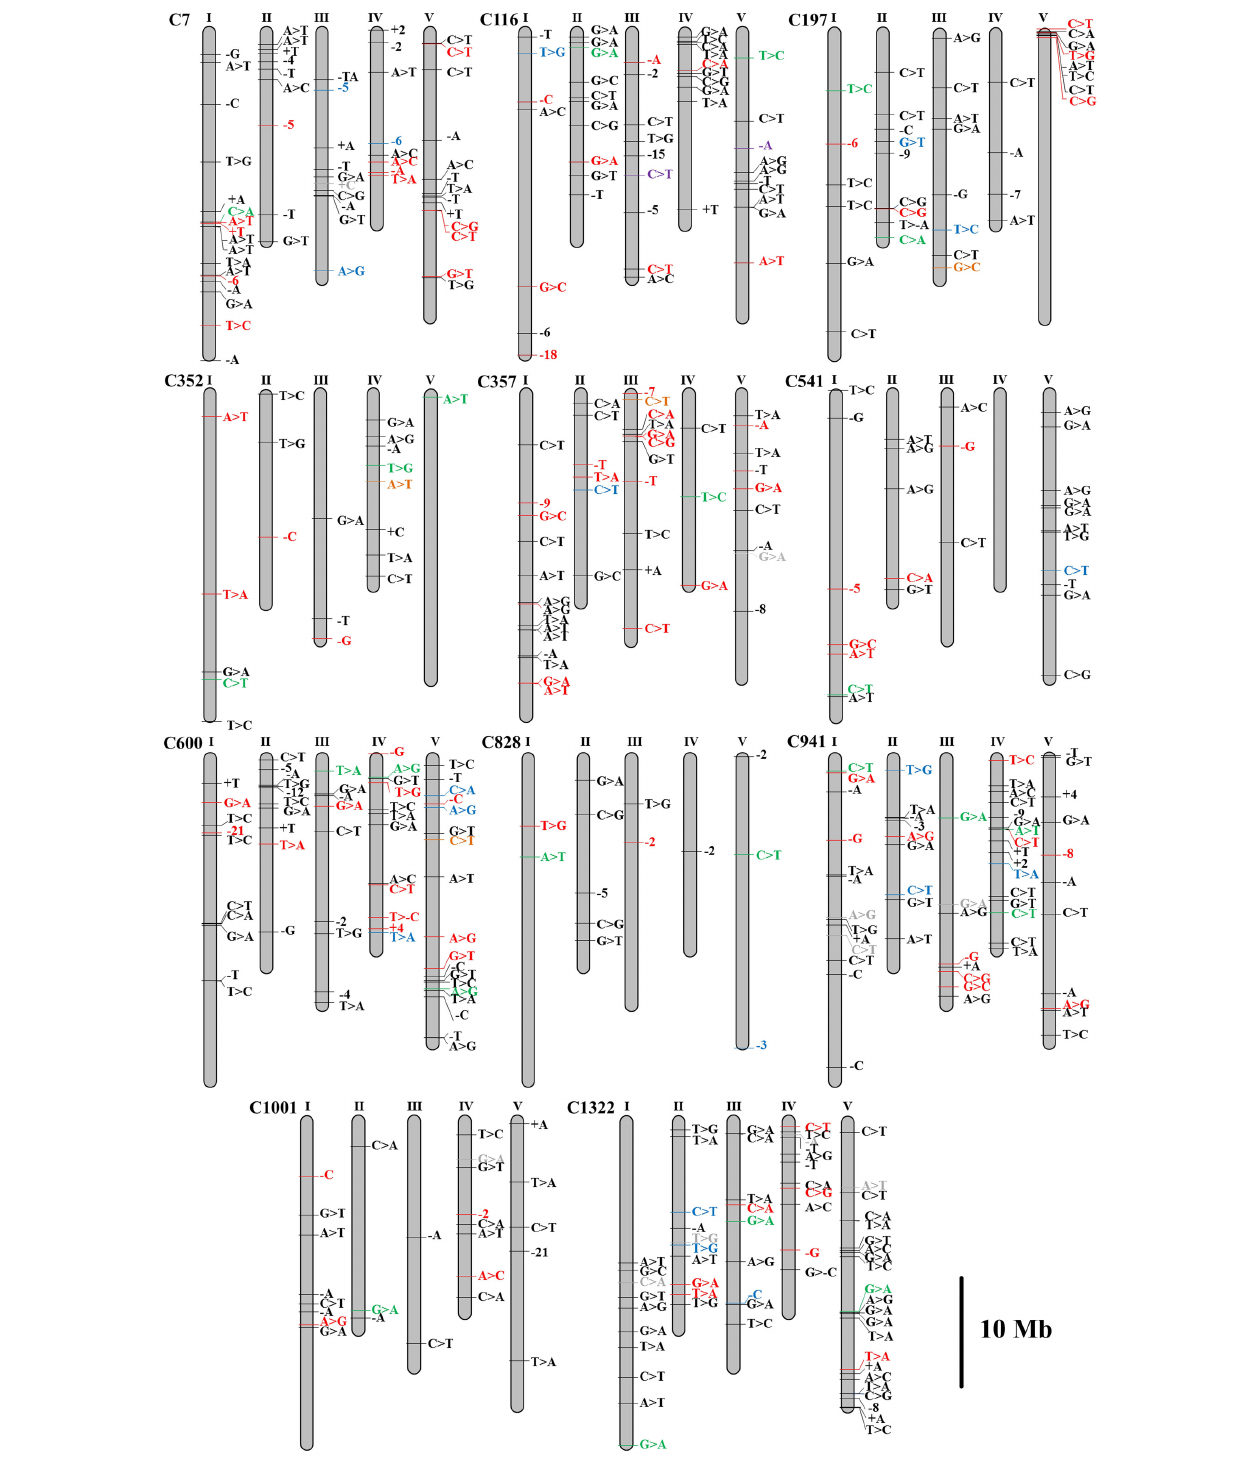
FIGURE 4 | Distributions of the substitutions and small INDELs across chromosomes in the genomes of 11 mutagenesis progeny lines (M3) of Arabidopsis thaliana . Single-base INDELs are indicated by base-designating letters, with a preceding minus sign (deletion) or plus sign (insertion). Multiple-base INDELs are indicated by a minus or plus sign with the number of deleted or inserted bases. Individual colors distinguish the possible mutation effects: missense, frame shift, in-frame deletion, stop gained/lost (red); synonymous (green); UTR (blue); splice site region, intron (orange); intergenic region (gray); up downstream regions (black); non-coding exon